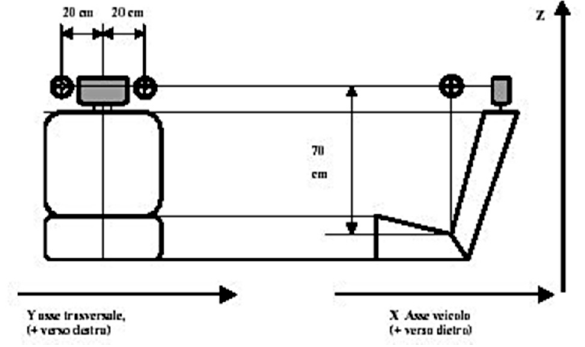
Figure 25. Positioning of listening point inside passenger